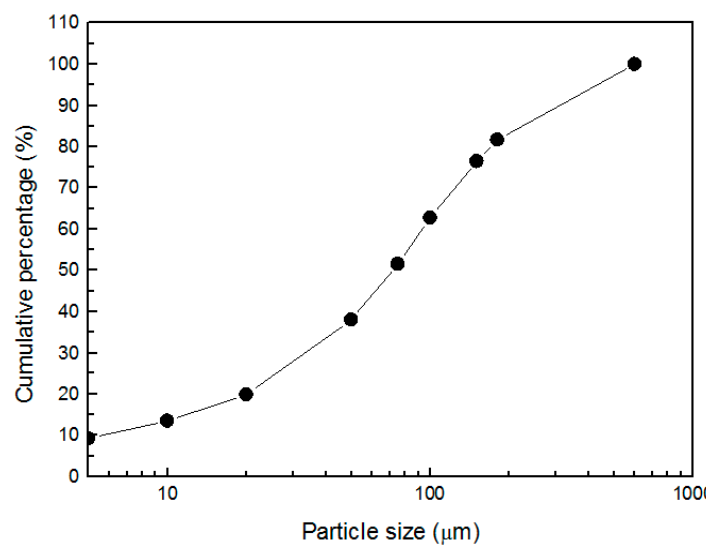
Figure 2. Particle size distributions of the Lilou full tailings.